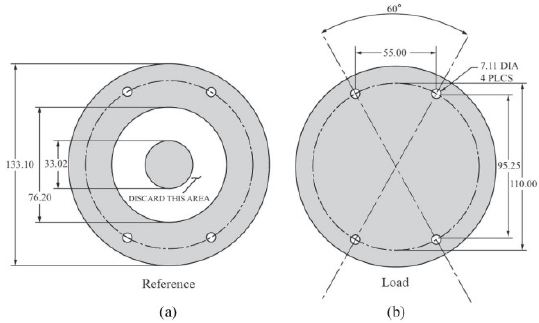
Figure 1. ( a ) Reference and ( b ) load specimens used for EMI-shielding measurements, with dimensions given in millimetres. Reprinted from [20], copyright (2021), with permission from Elsevier.